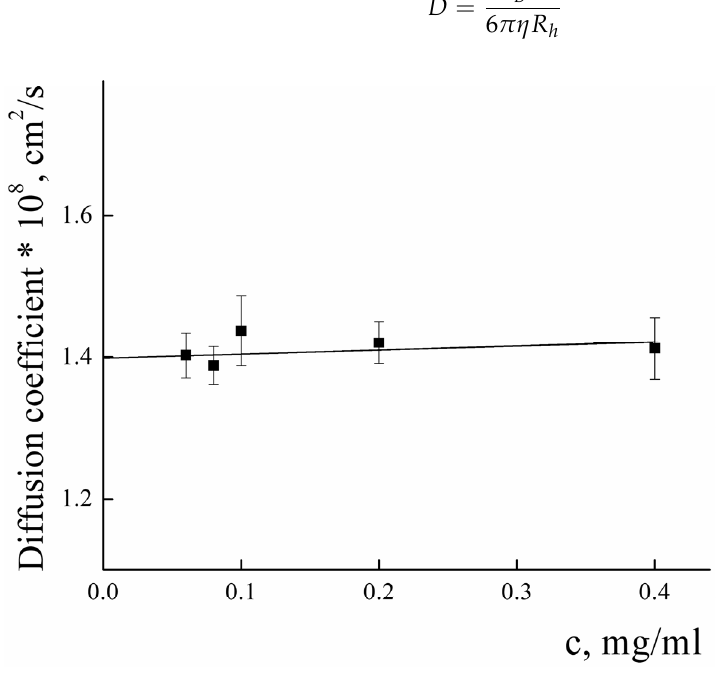
Figure 4. Concentration dependence of the diffusion coefficient of PLAMs–us in Tris buffer with pH 7, c = 0.01 M, 25 °C.